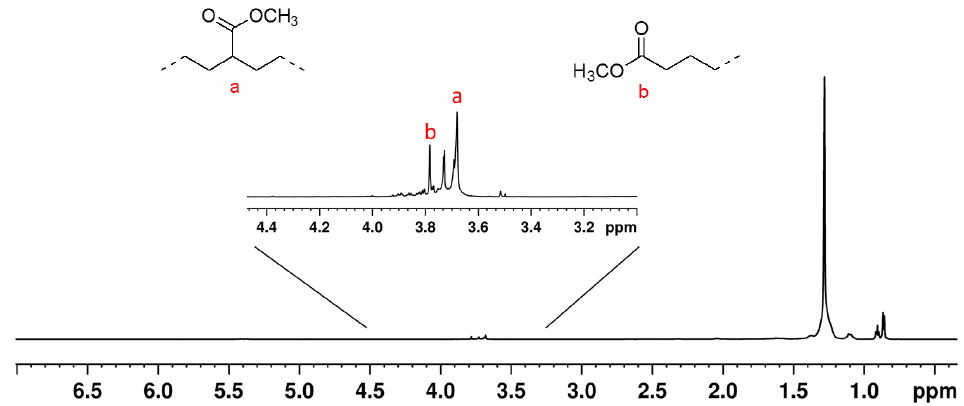
Figure 4. 1 H NMR (C 2 D 2 Cl 4 , 600 MHz, T = 298 K) spectrum of the copolymer sample of run 3, Table 1.